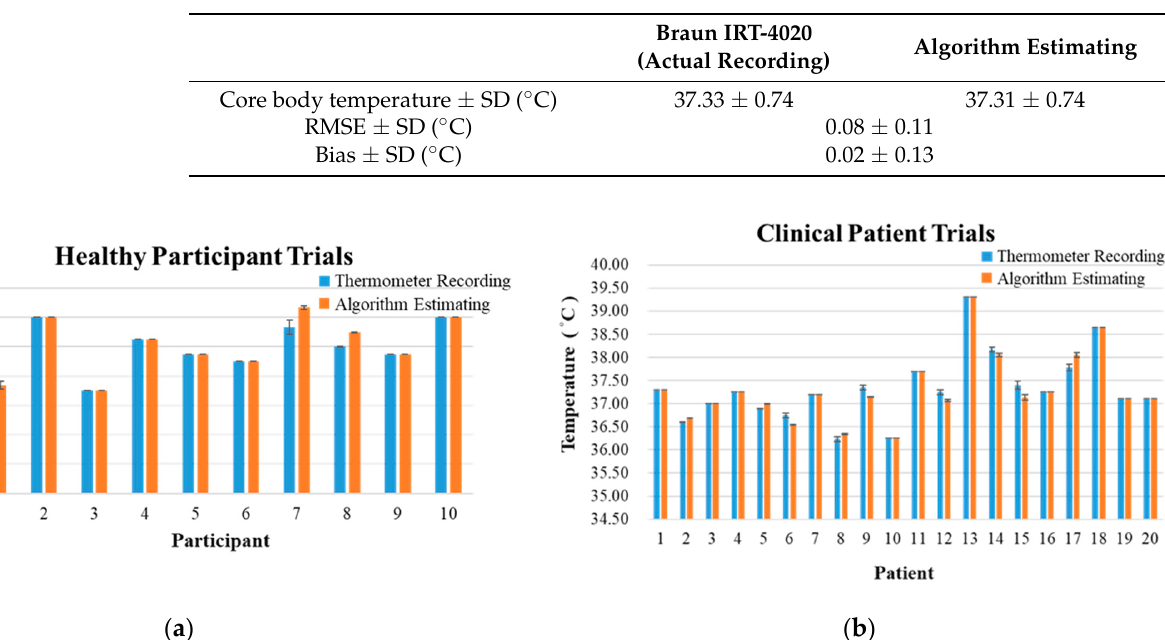
Table 6. Core body temperature estimation algorithm results (clinical patient).